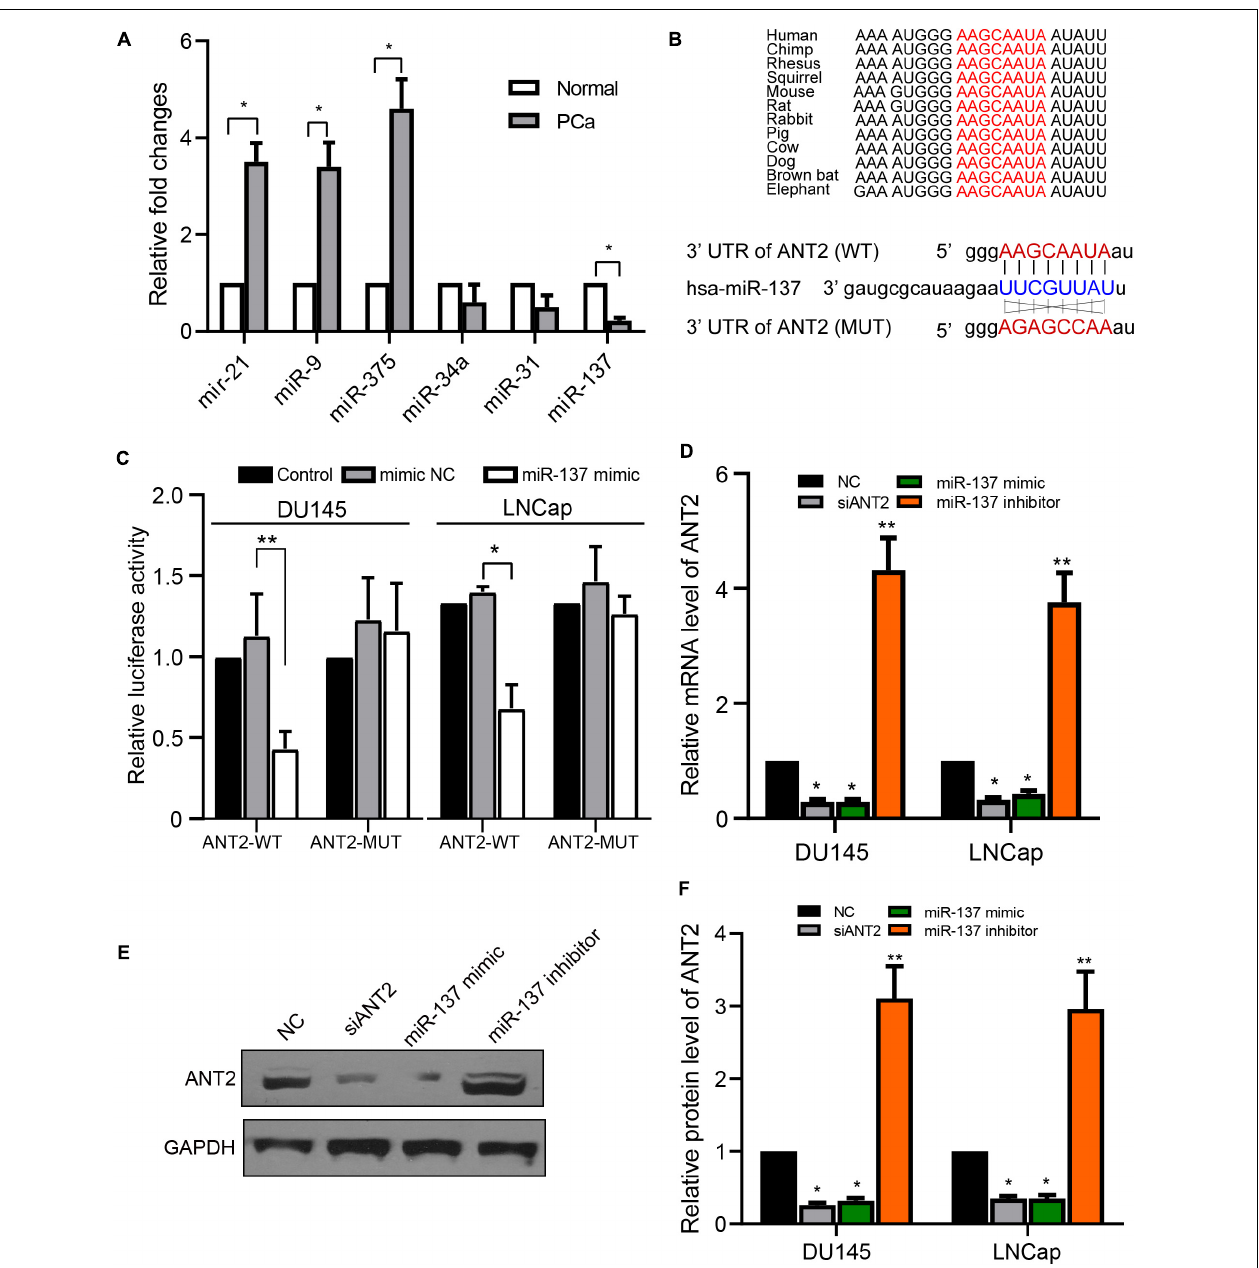
FIGURE 4 | ANT2 is a target gene of miR-137. (A) Prostate cancer and normal tissues were subjected to qPCR to detect the indicated miRNAs. Expression of miR-137, as determined by qPCR, was reduced in prostate cancer samples. (B) TargetScan predicted the presence of a conserved regulatory site for miR-137 in the UTR region of ANT2. The sequences of the WT and MUT 3 (cid:48) -UTR of ANT2 targeted by miR-137 are shown. (C) In LNCaP and DU145 cells, miR-137 mimics decreased luciferase activity in ANT2 3 (cid:48) -UTR (wild-type) but had no statistically significant effect on luciferase activity in ANT2 3 (cid:48) -UTR (mutant). (D) DU145 and LNCaP cells were transfected with miR-137 mimic/inhibitor or siANT2 fragments. Expression of mRNA encoding ANT2 was detected by qPCR. (E,F) Cells were treated as in panel (D) and cell lysates were subjected to western blot analysis with the indicated antibodies. * p < 0.05; ** p <